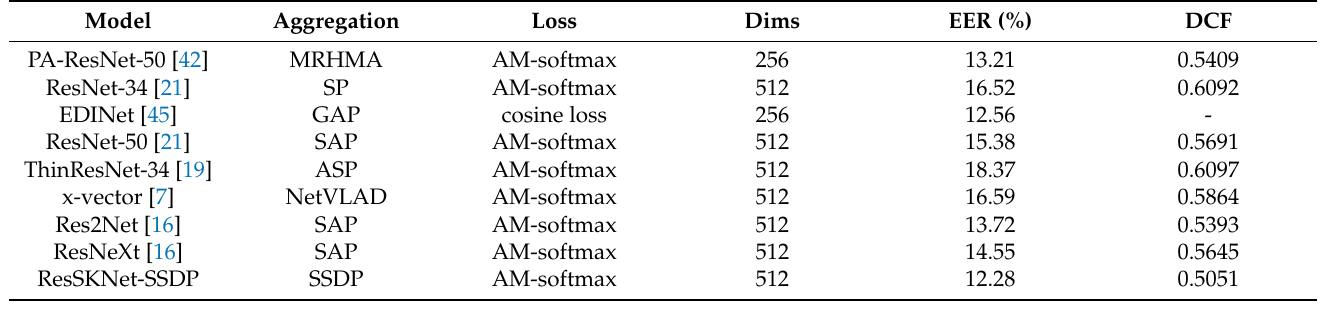
Table 8. Results of different systems on the CN-celeb test set.